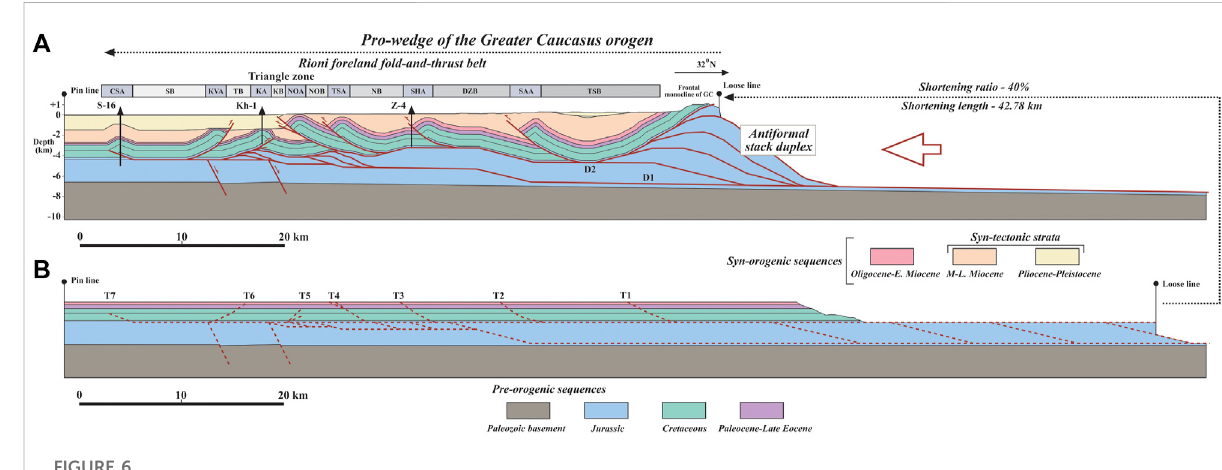
FIGURE 6 (A) Balanced — A-A I and (B) restoredcross-sections.LocationisshowninFigures1,2.Abbreviations:T1-T7 —